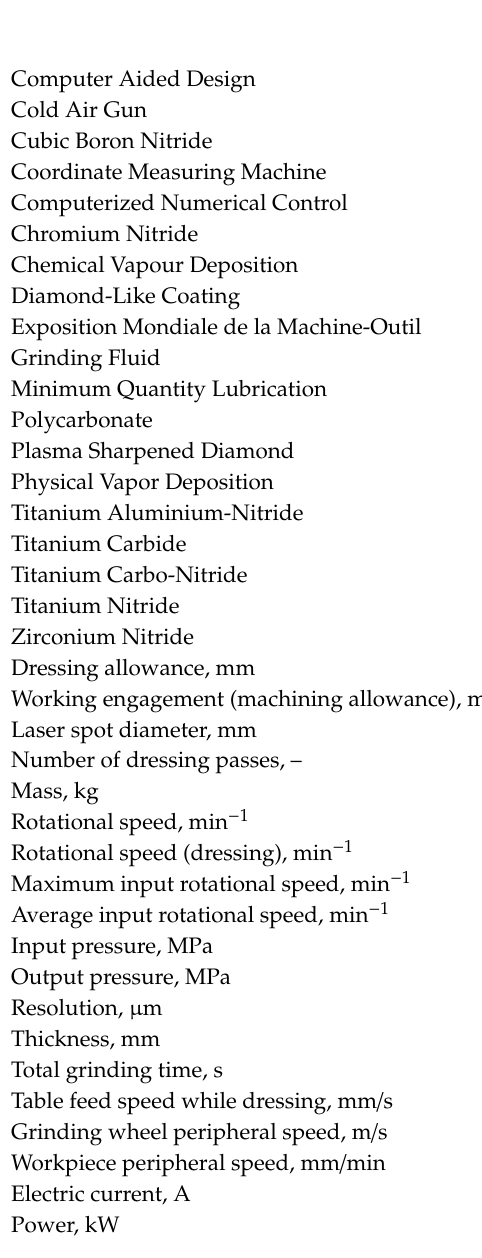
Table feed speed while dressing, mm /